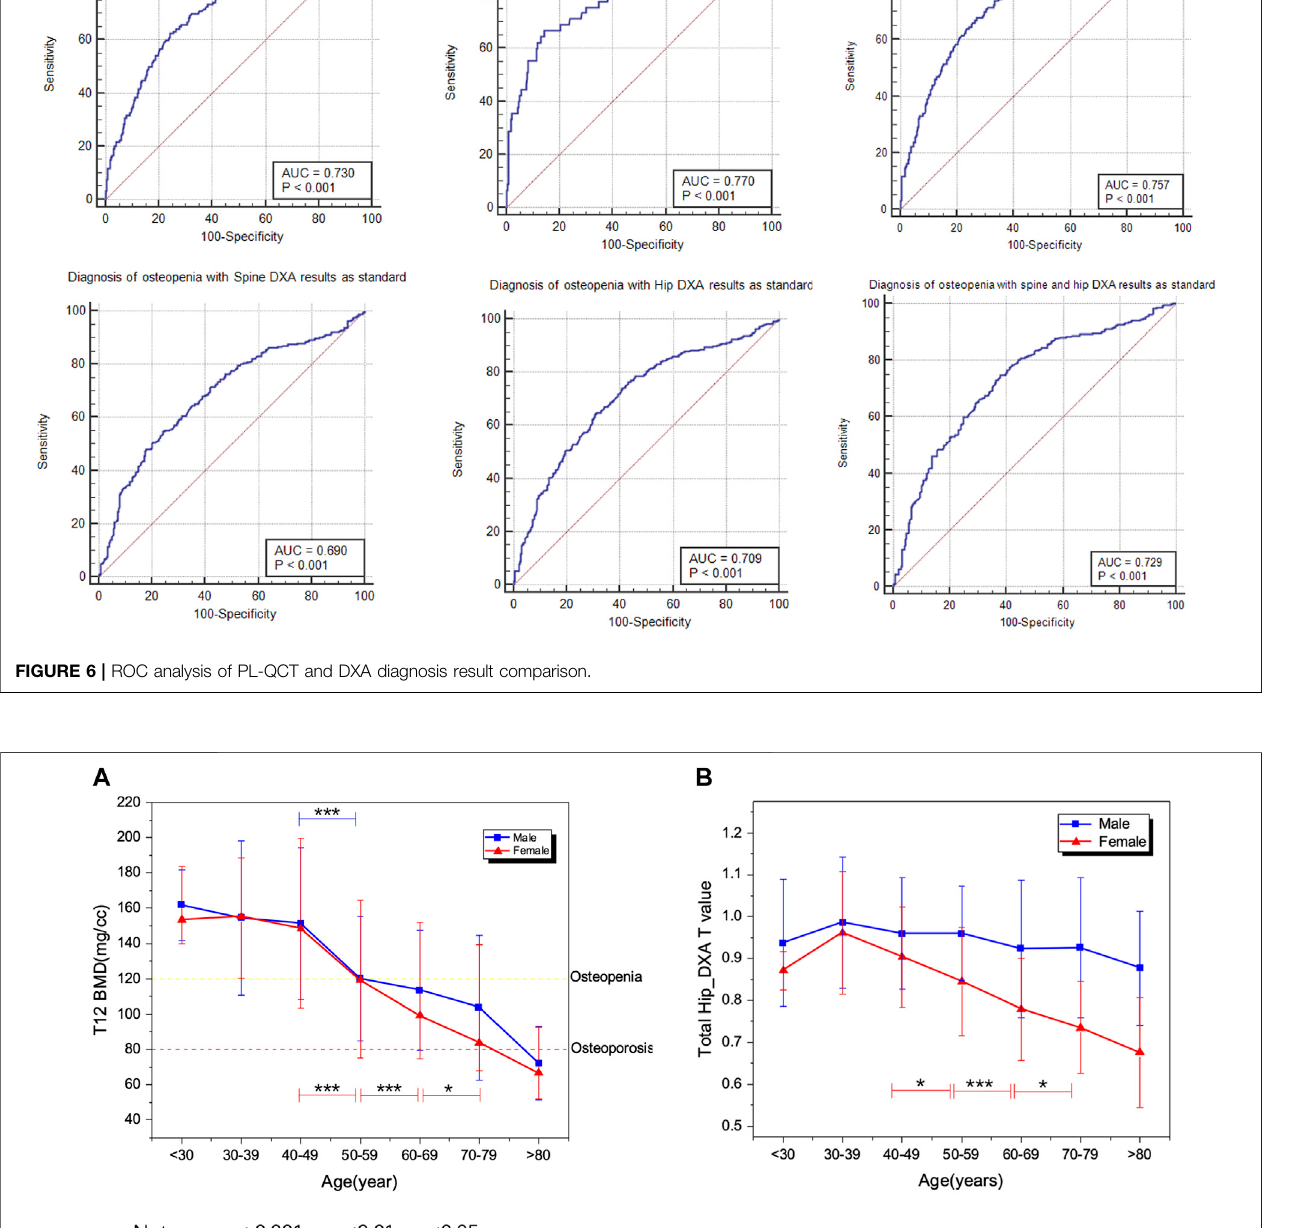
Frontiers in Bioengineering and Biotechnology |